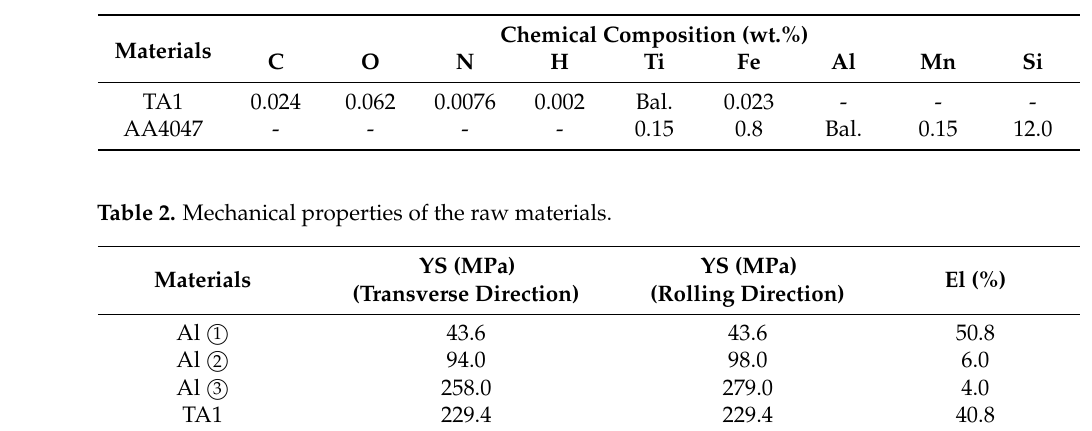
Table 1. Chemical composition of the raw materials.